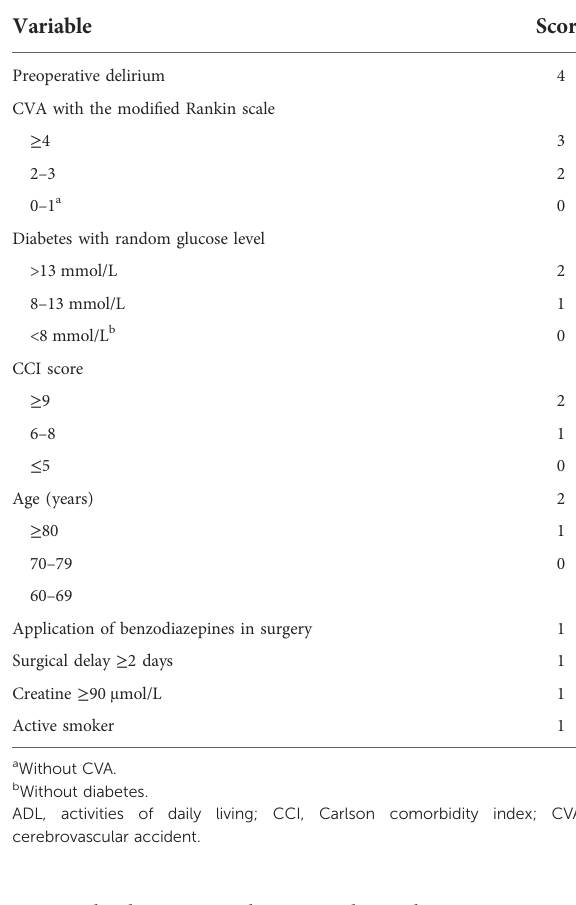
TABLE 2 Multivariate regression of postoperative delirium. TABLE 3 Prediction score of postoperative delirium for patients after hip fracture surgery or hip